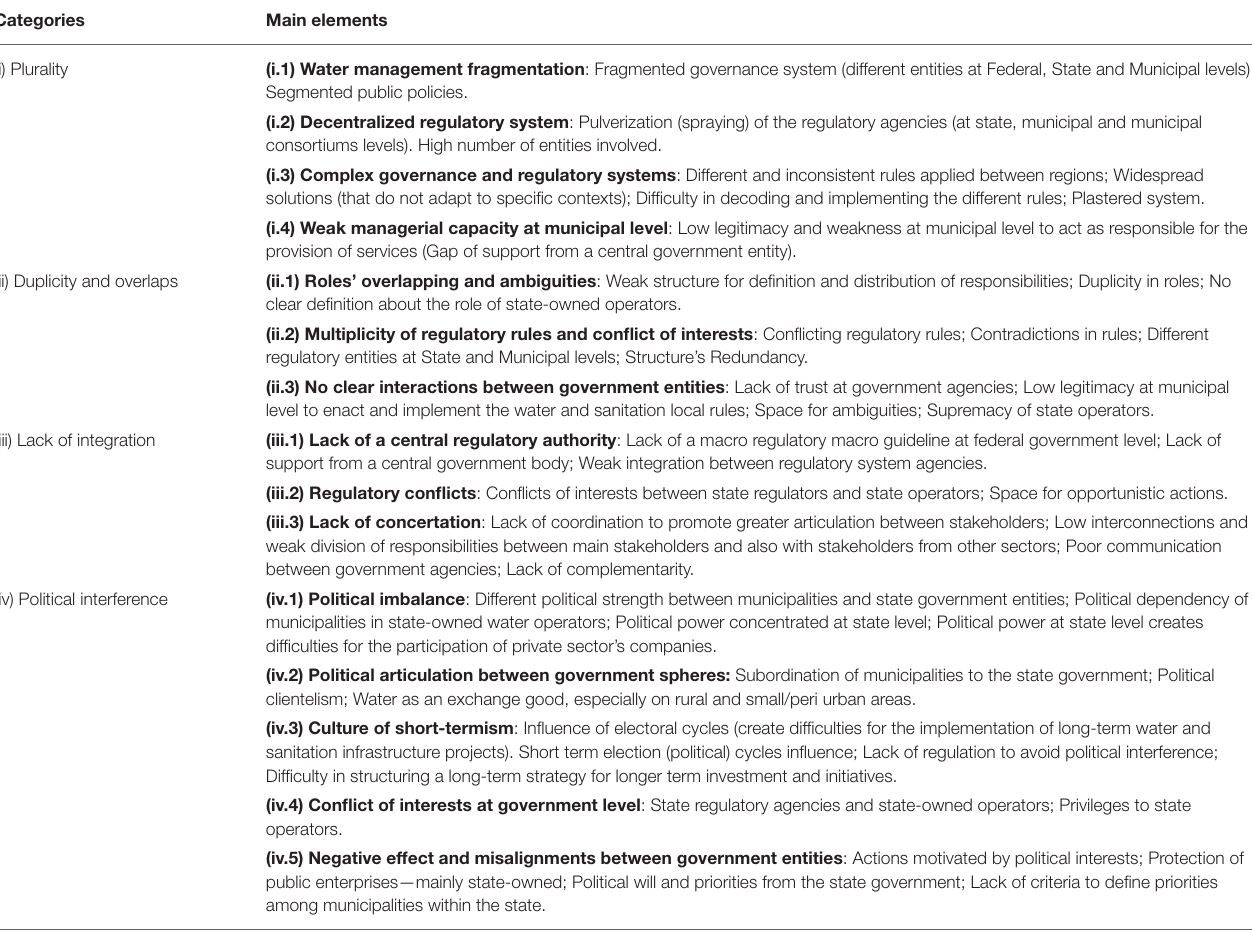
TABLE 3 | Institutional constraints—institutional complementarities in the governance and regulatory system: categories and main